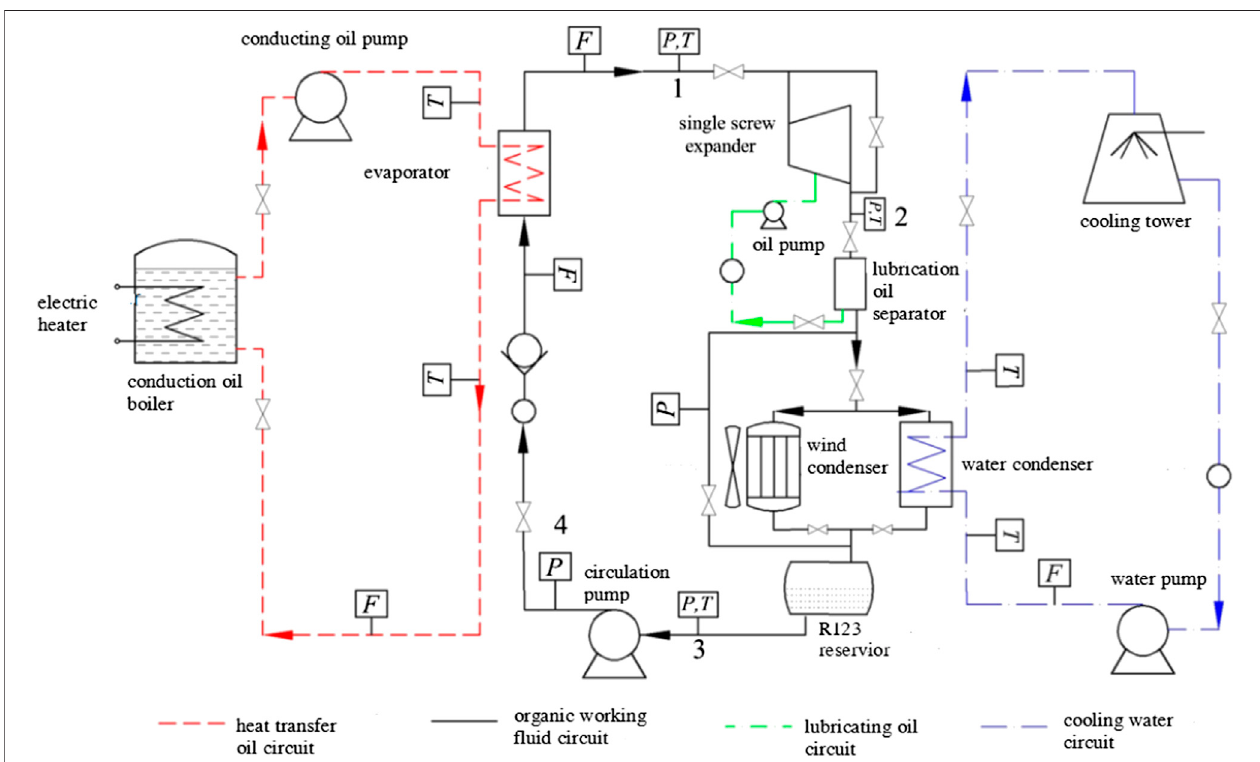
FIGURE 1 | Schematic diagram of the experimental Organic Rankine Cycle